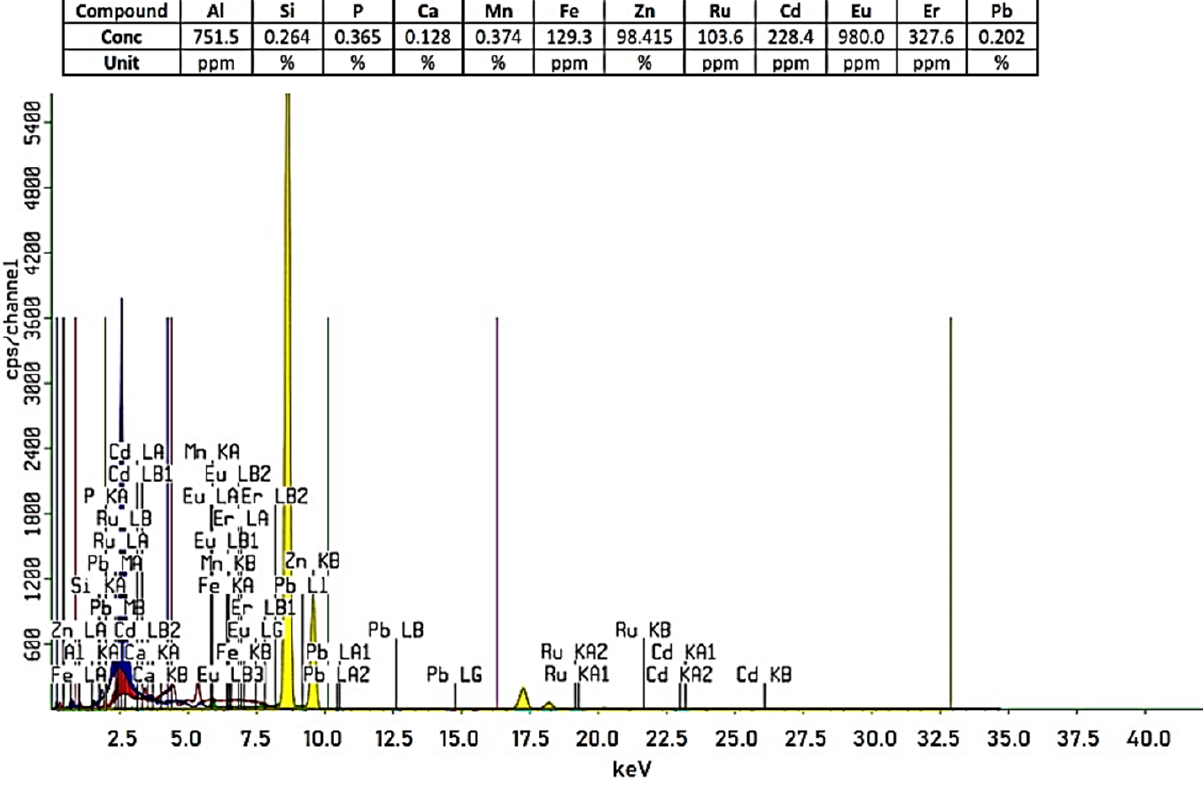
Figure 2. Chemical composition of ZnO from XRF analysis.